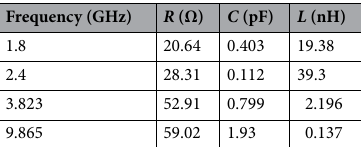
Table 2. RLC parameters of the equivalent